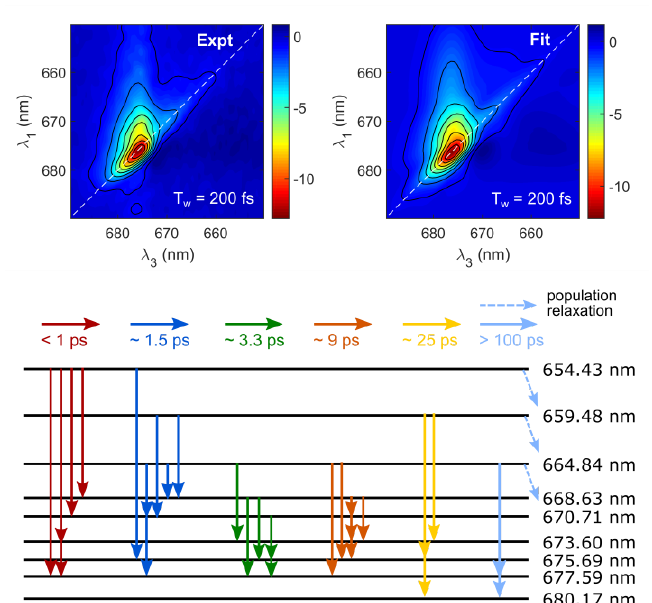
Fig. 2. Comparison between the experimental (top-left) and fitted (top-right) 2DES spectrum at T w = 200 fs. Energy levels with EET rates indicated by the arrows resulting from our fitting procedure (bottom). All rates slower than 500 ps are